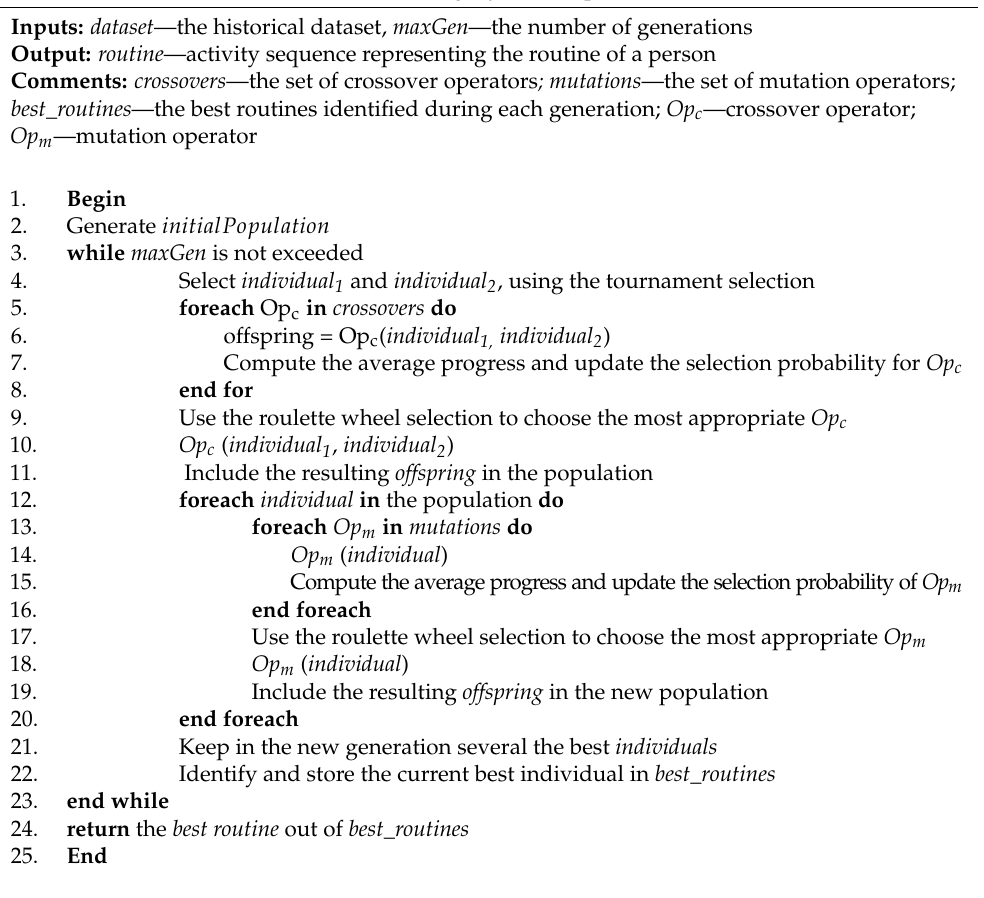
Algorithm 1 : GA for Routine Detection Using Dynamic